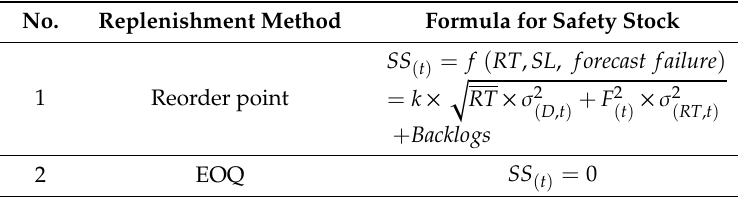
Table 3. Safety stock calculation (own elaboration).